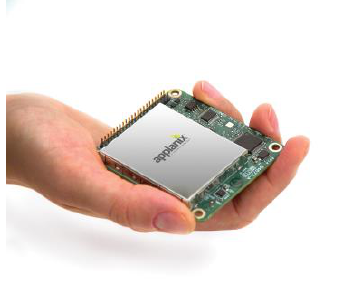
Figure 2: Applanix APX-15 UAV Single Board GNSS-Aided Inertial solution for Direct Georeferencing on